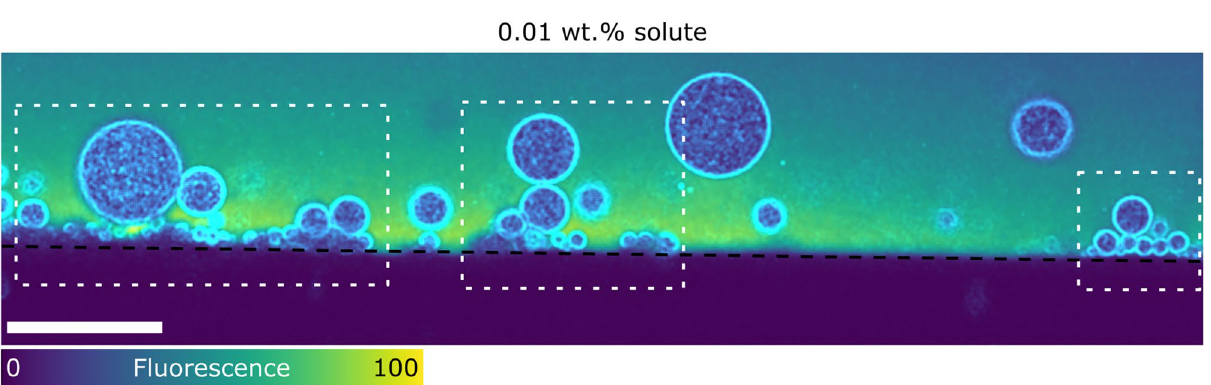
Figure 8. Interaction of polydisperse oil-in-water emulsion with an advancing ice-water front at 0.01 wt.% bulk solute concentration. The droplets with radii smaller than the critical radius ( R x < R c ) get pushed by the steady- state planar front and lead to the formation of clusters by blocking the arriving droplets ( R x < R c < R y ). Oil is in cyan, water in colormap viridis (fluorescence bar) while ice is in black. Scale bar = 100 µ m . © (2020) S. Tyagi et al. (10.6084/m9.figshare.13176221) CC BY 4.0 license https ://creat iveco mmons .org/licen the imposed growth rate. Ideally, we expect the engulfment of objects with R y > R c and rejection of objects with R x < R c , where the critical radius is 9 µ m for our experimental parameters. However, we observe the repulsion of miscellaneous droplets irrespective of their radii ( R x < R c < R y ), as seen in Fig. 8, in the absence of long- range solute effects. The droplet clusters form at the front with the primary layer occupied by the small droplets ( R x < R c ), which further creates a barrier and facilitate the repulsion of relatively larger droplets ( R y > R c ). For planar front solidification in the presence of solute, the previous models 19,21,33,34 deduce a critical engulf- ment velocity which in most cases is an order below the critical velocity for isolated objects in pure materials. The models suggest either an absence of pushing-engulfment transition, or a destabilisation of the steady-state planar front prior to engulfment. In both scenarios, rapid engulfment of the object is suggested as the most favorable outcome, facilitated by an increase in the viscous drag forces. However, the presence of multiple-particle